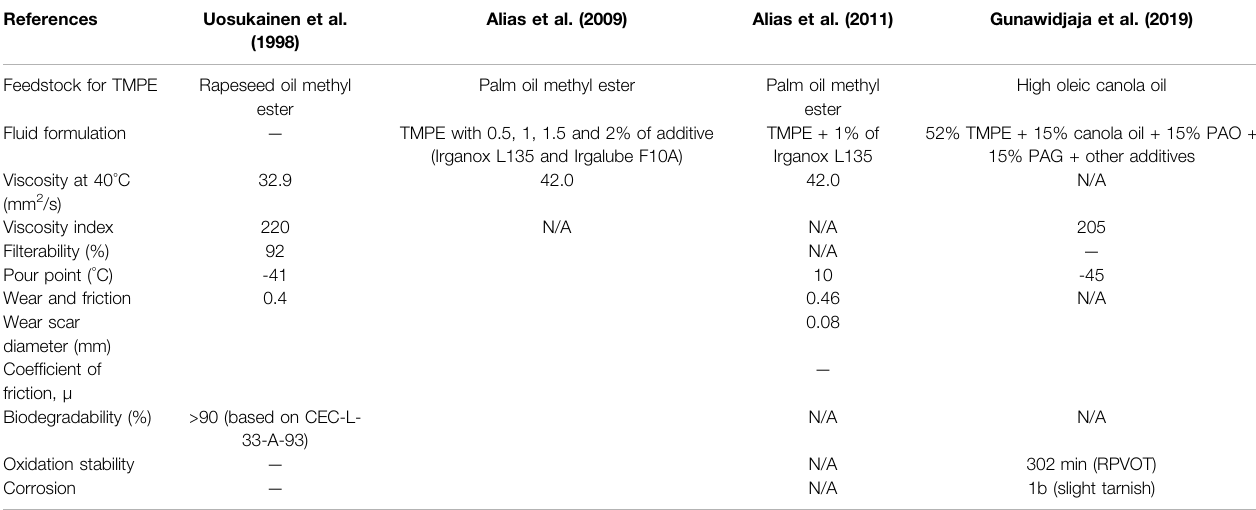
TABLE 9 | Previous studies on the application of TMPE as a biodegradable hydraulic fl